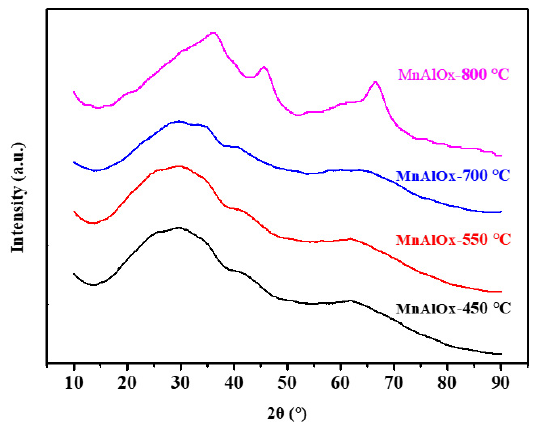
Figure 5. Wide-angle XRD patterns of mesoporous MnAlO x catalysts.